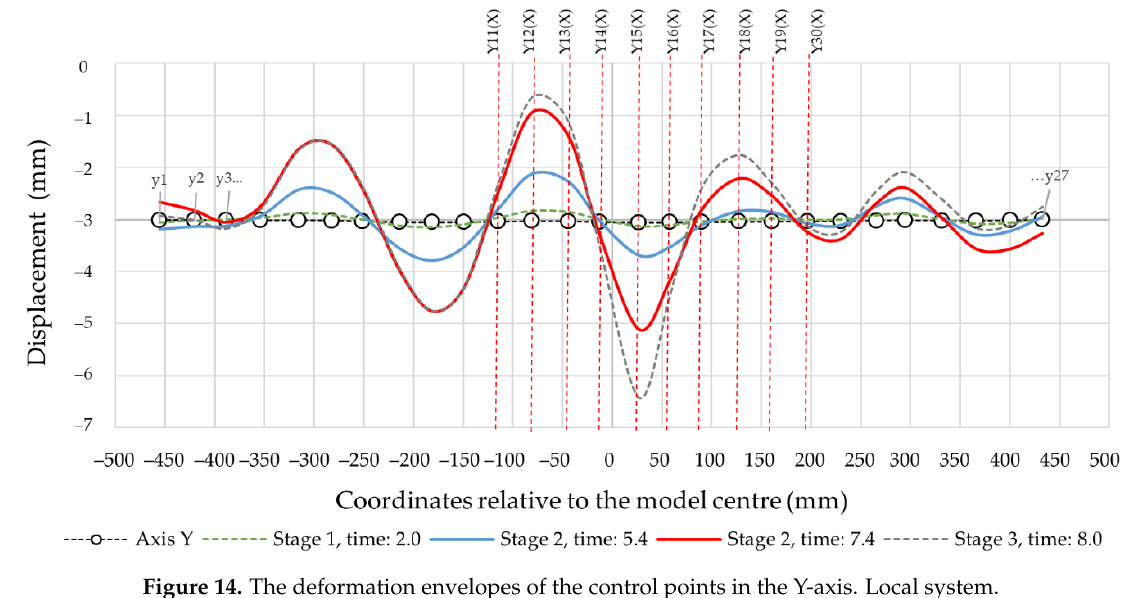
Figure 13. The deformation lines of the numerical model in the longitudinal section at stage 2, time: 7.4.